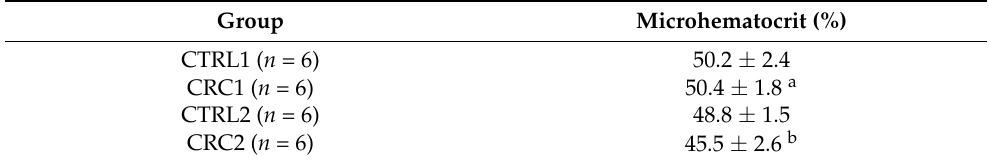
Table 2. Small intestine, cecum, and colon + rectum relative weight in all groups. Data are presented as mean ± SD.